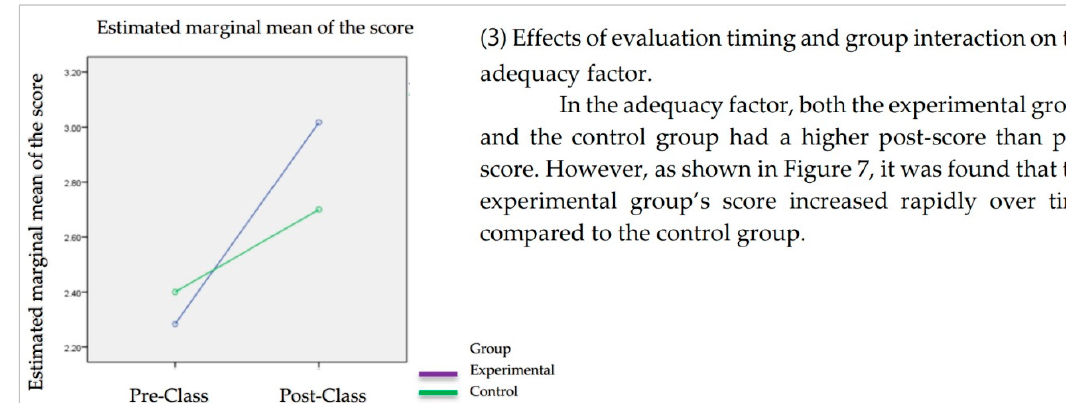
Figure 6. Effect of timing and group interaction on Attention.